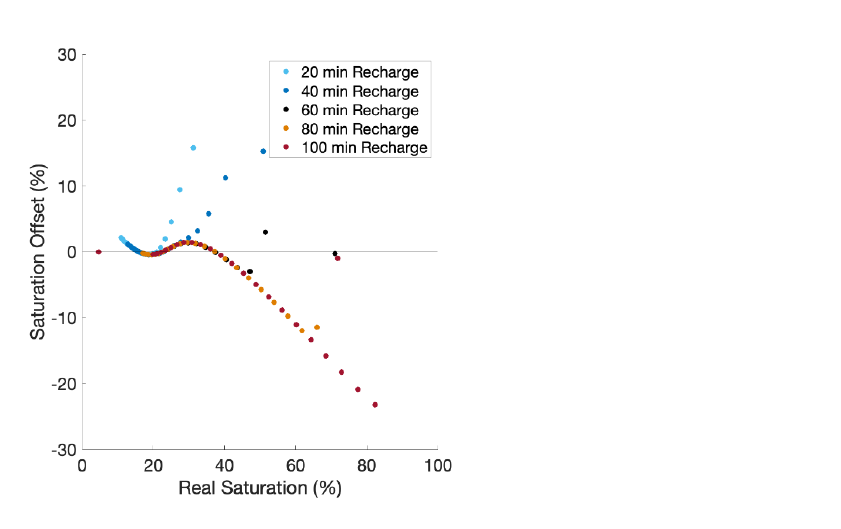
Figure 7. Results for simulations with shorter and longer recharge periods compared to the default 1 hr recharge. All simulations have a constant recharge rate of 20